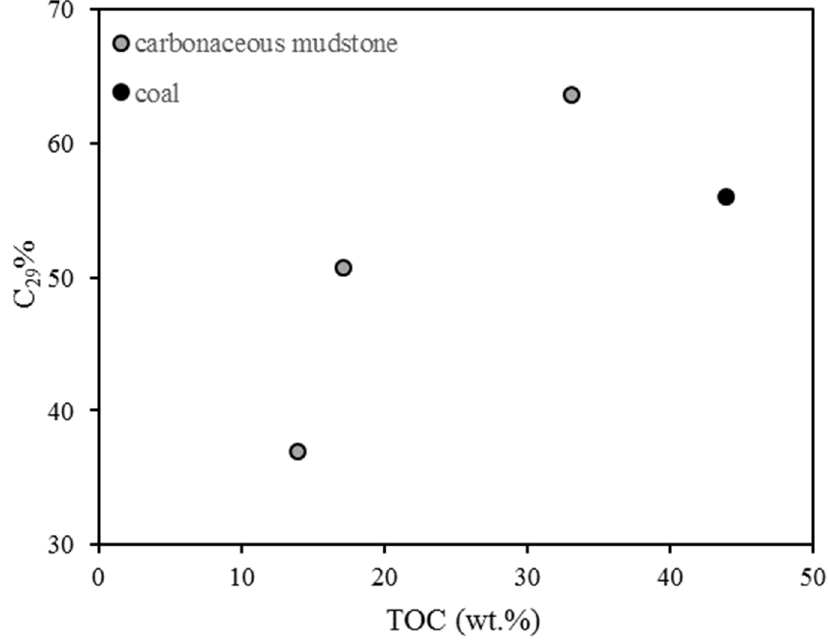
Figure 14. Relationship between C 29 sterane content and TOC for carbonaceous mudstone and coal.